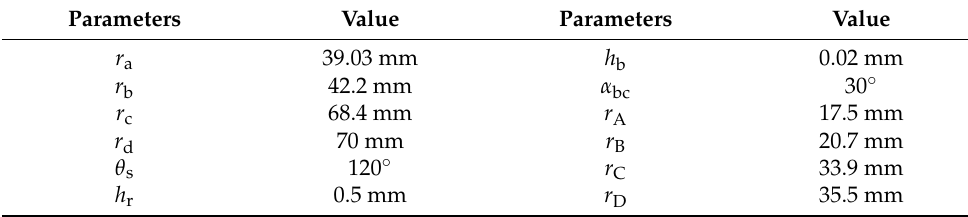
Table 3. Parameters of the front hydrostatic bearing.